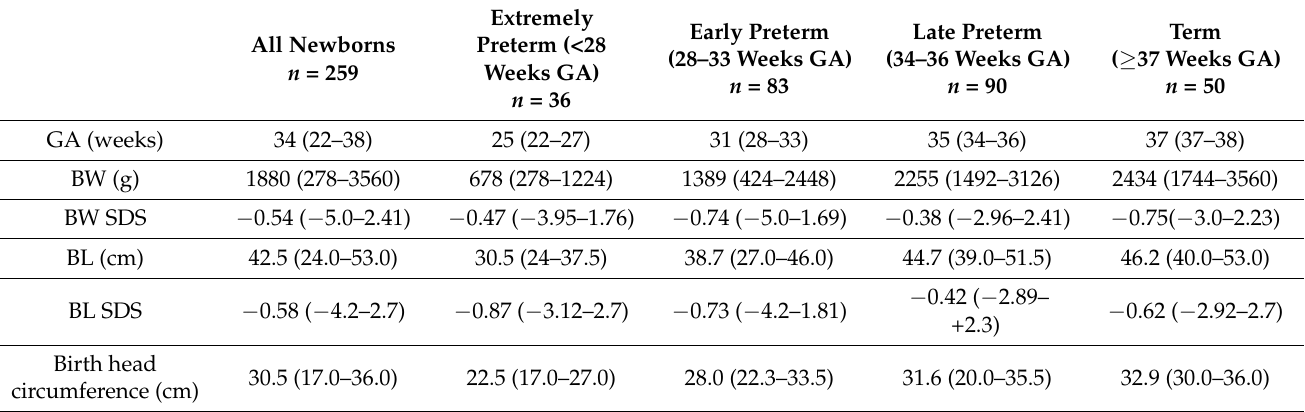
Figure 1. Umbilical cord IGF-1 levels in male and female newborns. IGF-1: insulin-like growth factor 1. Table 1. Umbilical cord blood IGF-1 levels classified by GA.